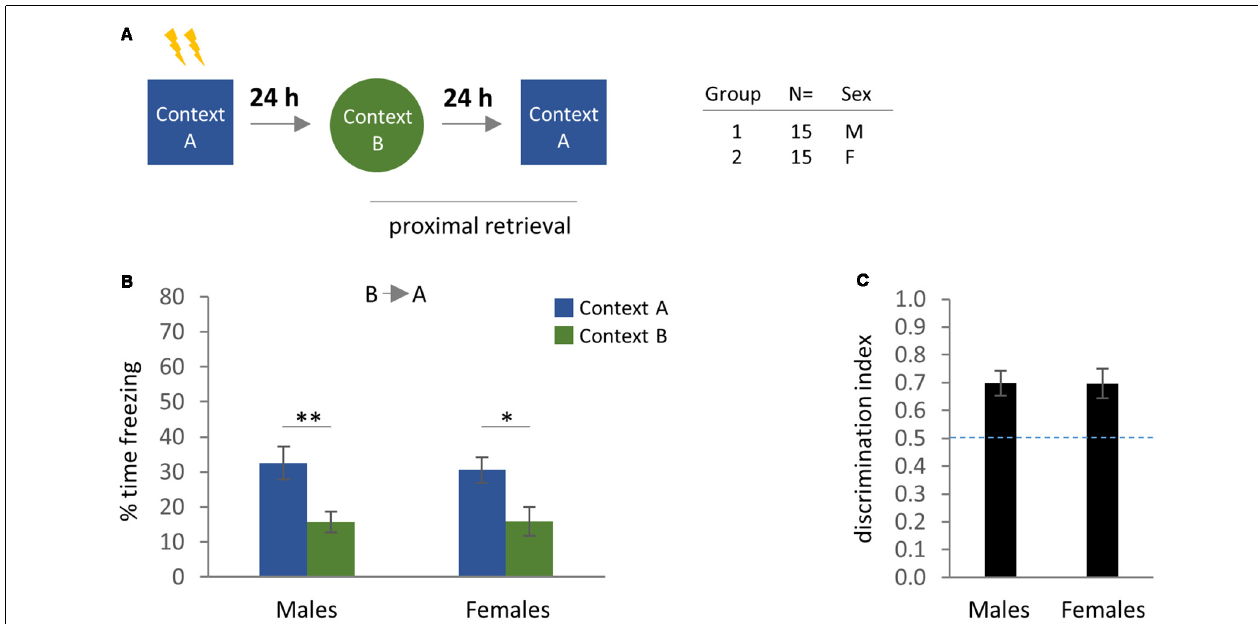
FIGURE 4 | Contextual fear memory and generalization at proximal time-points (BA test order). (A) Experimental design and cohort information. (B) Comparison of freezing behavior in male and female mice at 24–48 h after conditioning, using distinct training and generalization contexts. Bonferroni post hoc comparisons following two-way ANOVA are indicated. (C) Discrimination index for males and females at 24–48 h after conditioning. ∗ p < 0.05, ∗∗ p < 0.01. Error bars are mean ±